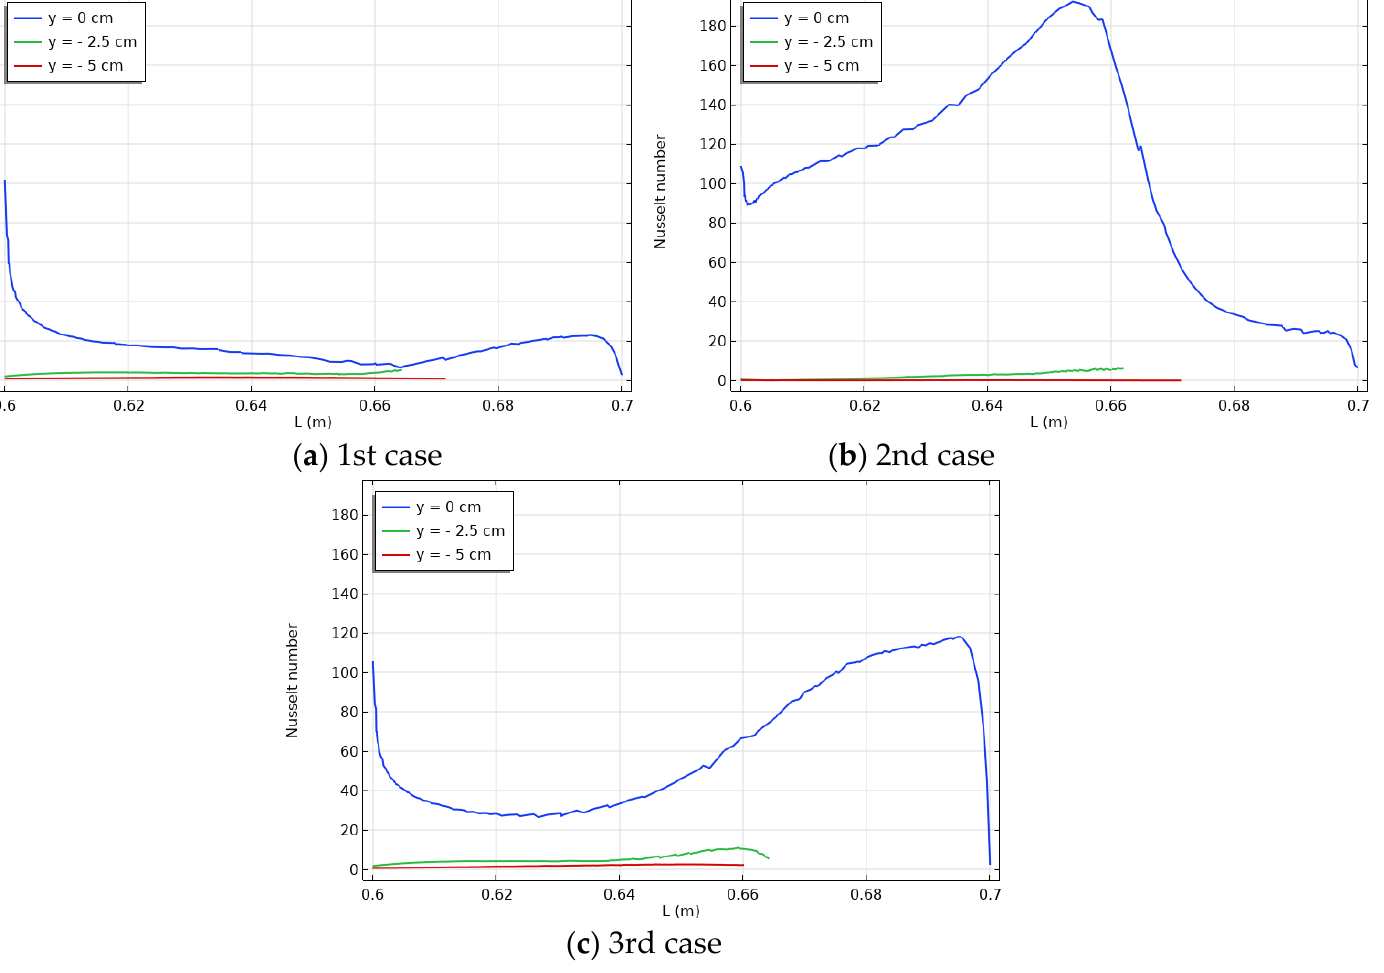
Figure 13. Local Nusselt number during the negative y axis in the cavity .